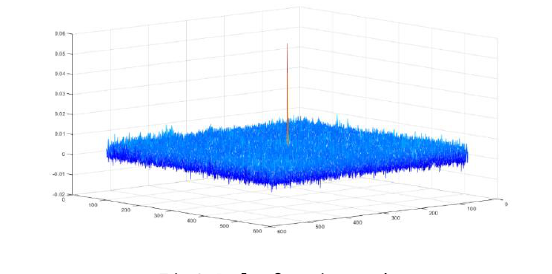
Fig 6. Pulse function peak